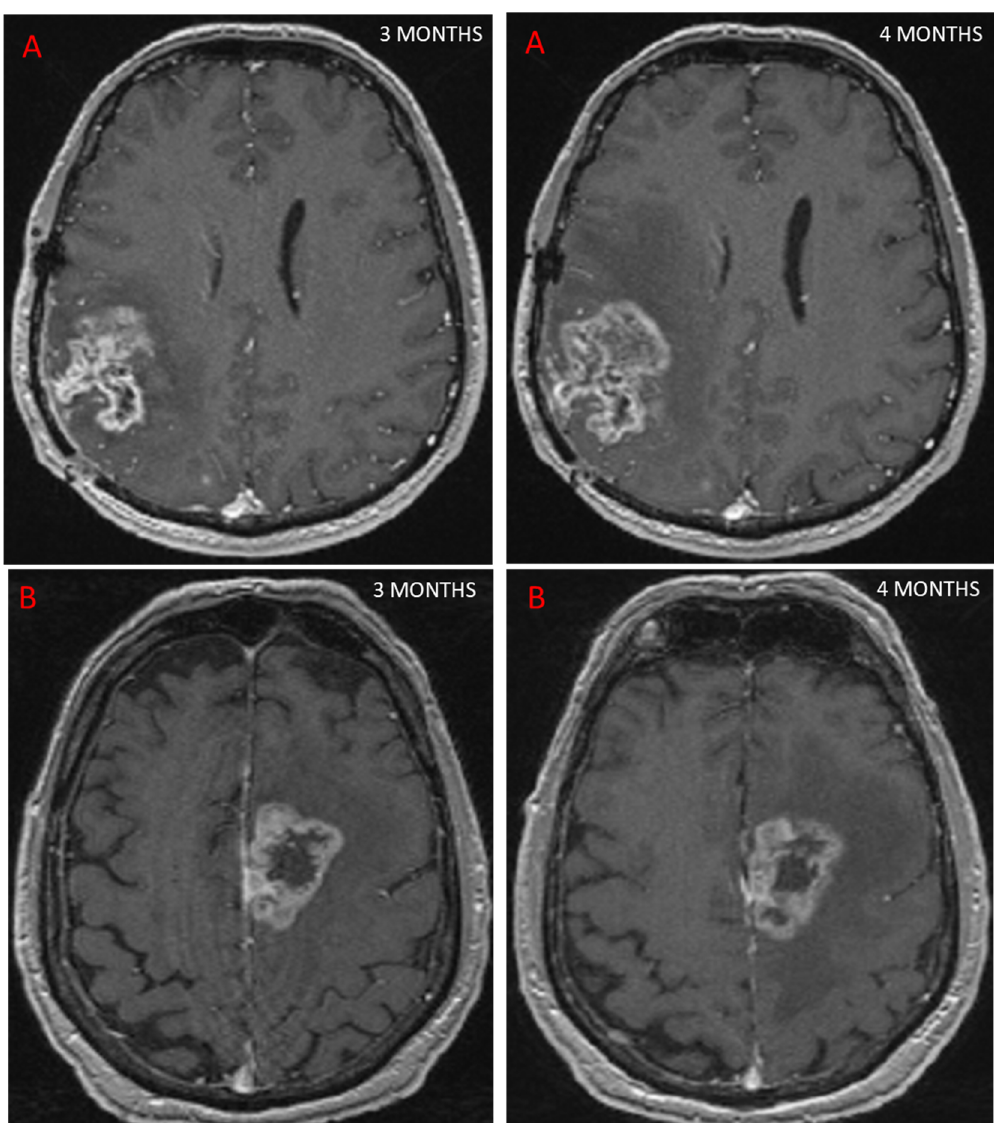
Figure 2. This figure shows two patients treated for GBM with concurrent RT and chemotherapy. At 3 months, MRI showed an increase in contrast-enhancing lesion on axial T1 sequence after injec- tion of a contrast agent, suggestive of progression in both cases. Further MRI scans performed 1 month later (4 months post-RT) showed that one patient had TP, with an increase in contrast ( A ), while the other patient had PsP, as the contrast remained stable ( B